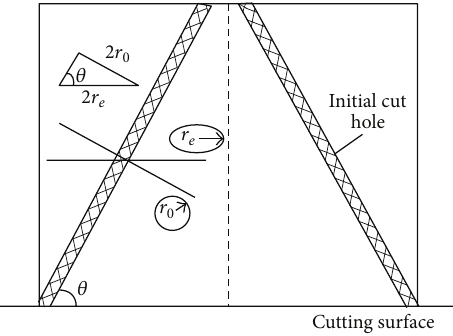
Figure 1: Initial cut hole with cutting surface.